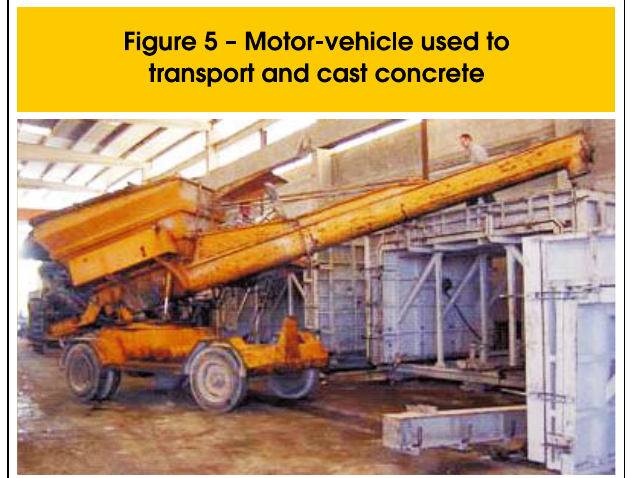
Table 2. Results concerning fresh SCC testing were